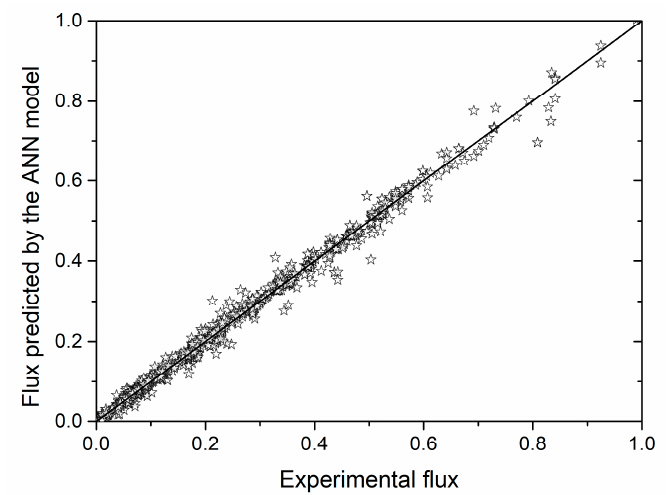
Figure 2. Normalized experimental permeate flux values plotted against the flux values predicted by the ANN (artificial neural network) model.